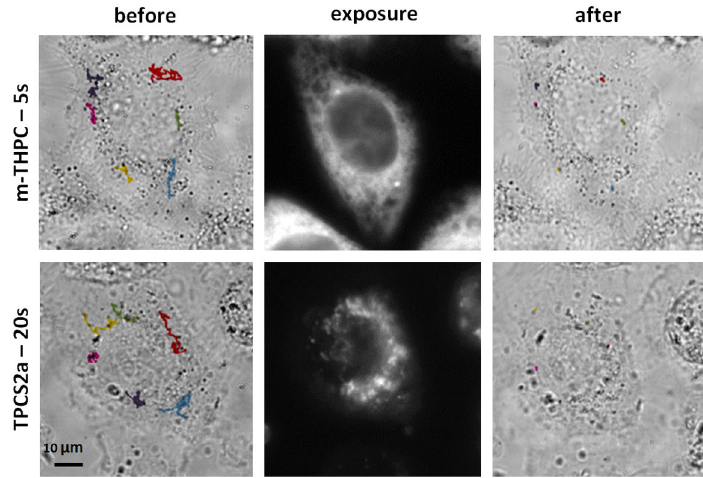
Figure 2. Monitoring of intracellular trafficking. The dark compartments (endosomes filled with magnetic nanoparticles) were followed for 100 s and their trajectories (before and after exposure) were superimposed on the image of the cell obtained at the outset of the monitoring phase. Movements were clearly inhibited by the action of the photosensitizer (mTHPC and TPCS2a, 5 s and 20 s of exposure,